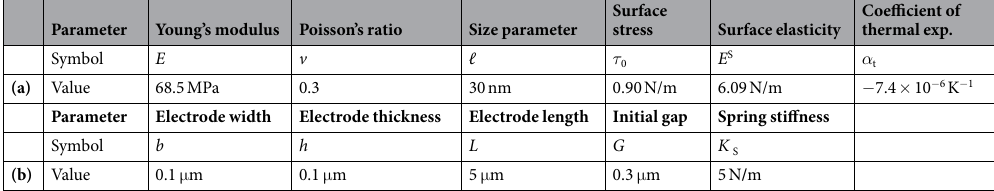
Table 4. Specifications of the microswitch (a) material properties 47 (b) dimensions.